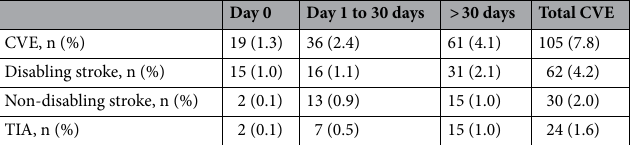
Table 3. Incidence of cerebrovascular events. CVE cerebrovascular event, TIA transient ischemic